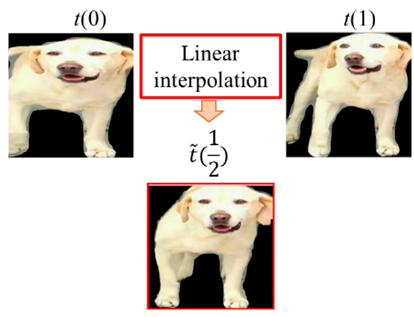
Figure 9. Linear image interpolation.